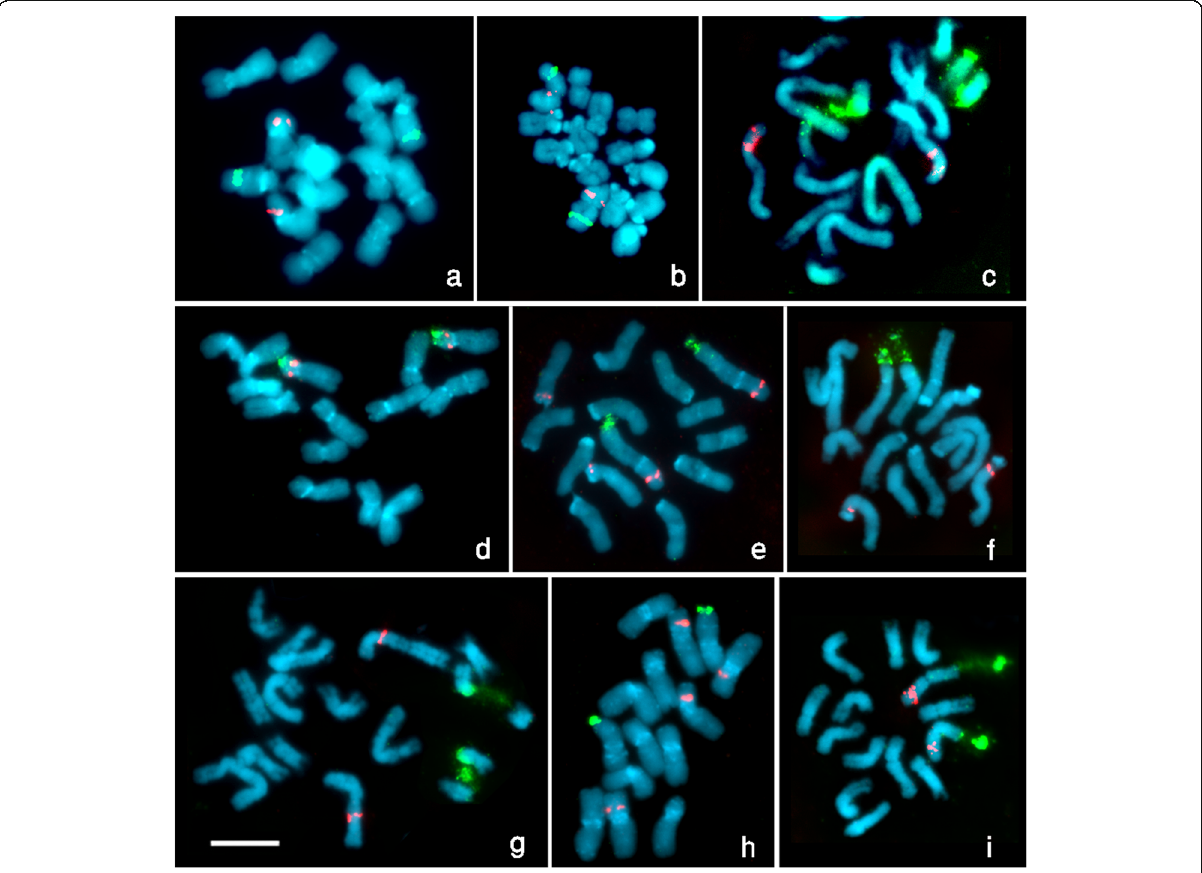
Fig. 1 Mitotic metaphase chromosomes of nine Lathyrus species after FISH with rDNA probes, 45S rDNA probe was detected by FITC (green signals), and 5S rDNA probe by Texas red (red signals). The chromosomes were counterstained with DAPI. Bar = 5 μ . a ) L. paranensis Burkart b ) L. nissolia L. c ) L. odoratus L. d ) L. hirsutus L. e ) L. amphicarpos L. f ) L. gorgoni Parl. g ) L. articulatus L. h ) L. sphaericus Retz i ) L. incospicuus